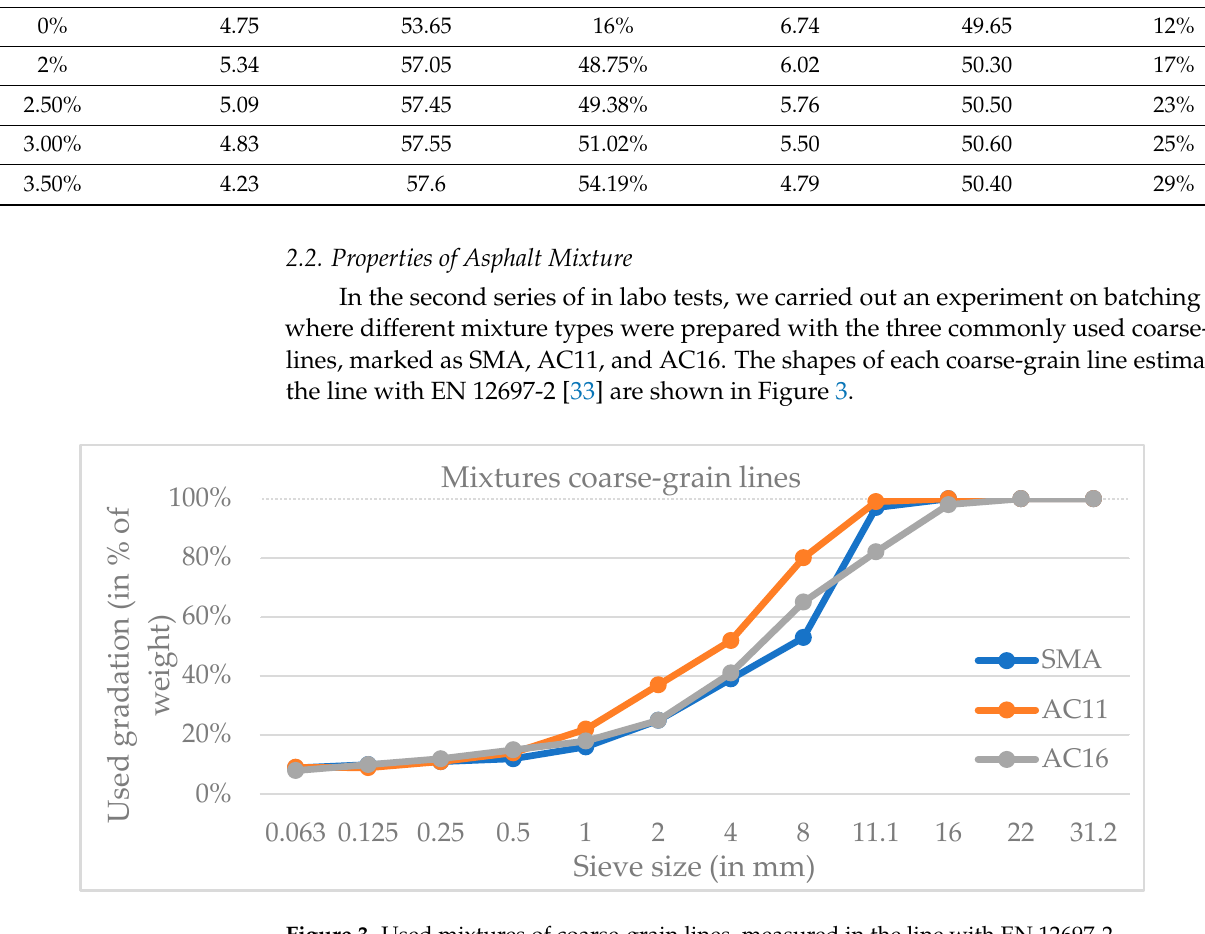
5 of 15 Figure 2. Testing devices from left to right—ring and ball, penetration needle, and ductility device. 2.1. Basic Properties of Bitumen and Modi fi er The result of the fi rst series of the in labo testing is shown in Table 1. As we can see, any additional modi fi cation of straight bitumen, as low as 2% of modi fi cation content, improves performance represented by a basic test of bitumen as softening point, ductility,